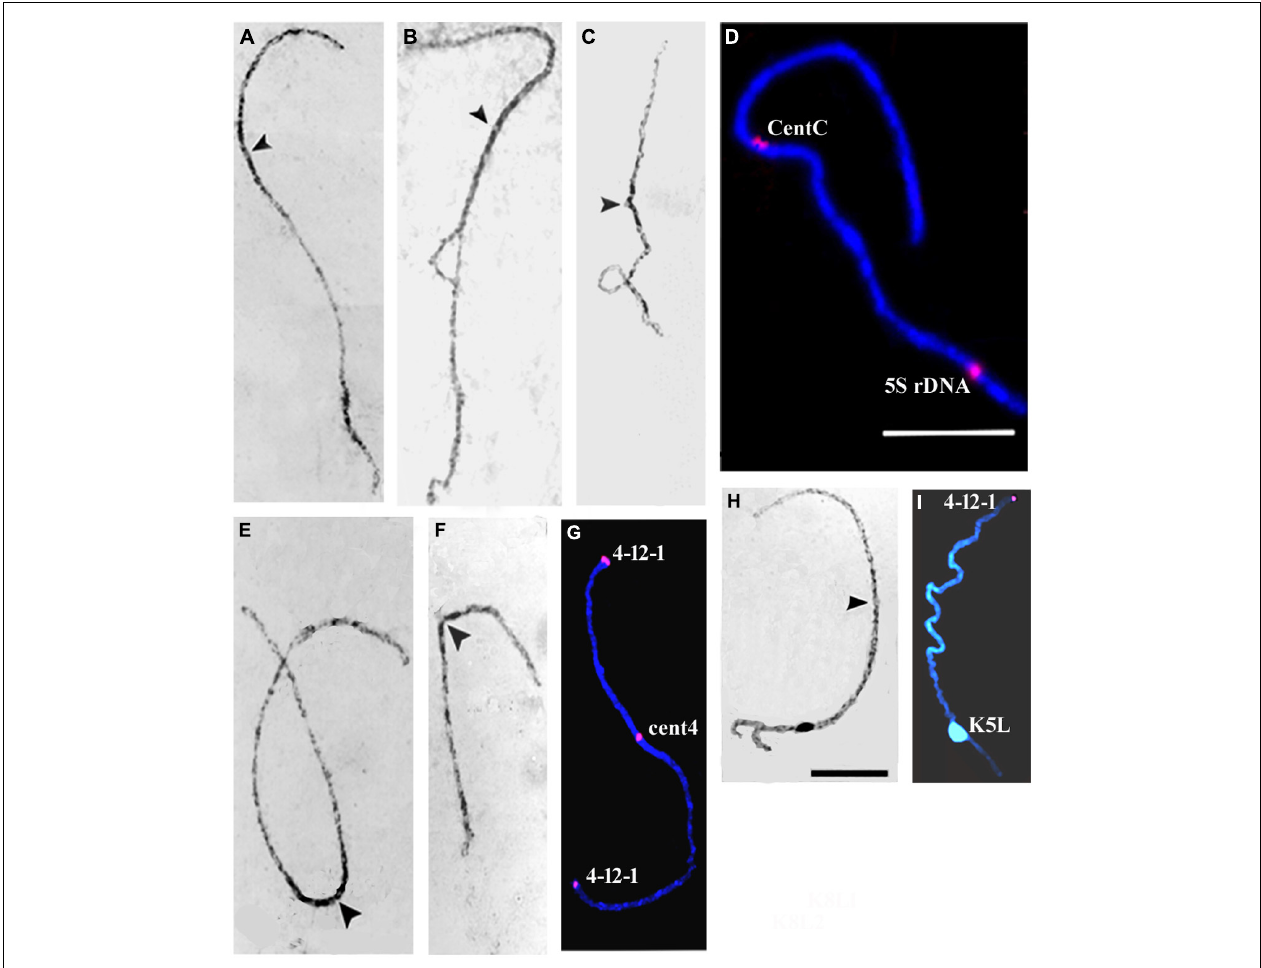
the centromeres in carmine-stained chromosomes (A–C,E,F,H) . FISH signals (red) of CentC and 5S rDNA probes on chromosome 2 (D) , Cent4 and subtelomeric 4-12-1 clone (red) on chromosome 4 (G) , and 4-12-1 on chromosome 5 (I) are displayed. Scale bars for carmine stained chromosomes and FISH images = 10 μ m.